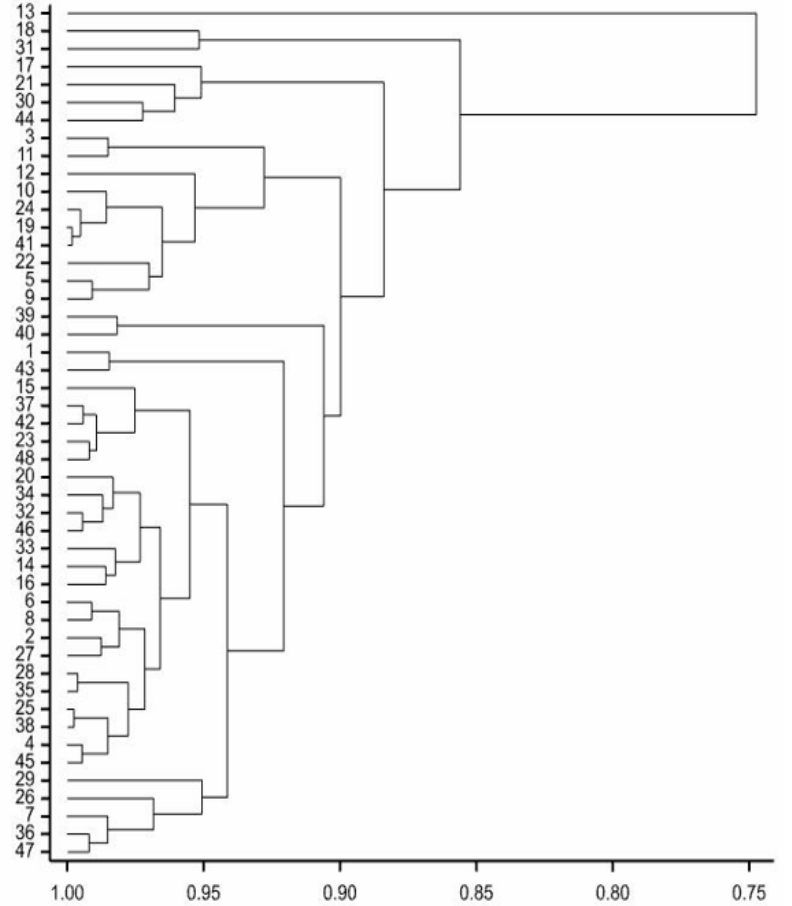
Figure 10. Dendrogram of differences between analysed Abies alba genotypes verified by the cluster analysis using the nearest neighbour method and Euclidean distances on the basis of eight traits (length of polar axis—P, equatorial diameter—E, width of the base of saccus—A, length of saccus—B, exine thickness—Exp, and P/E, Exp/P and A/B ratios). Numbers from 1 to 48, see Table 1. Individual traits were of different importance and had a different share in the joint multivariate variation. The study on the multivariate variation for A. alba genotypes also included the identification of the most important traits in the multivariate variation of the genotypes. Figure 10 shows the variability of the eight quantitative traits of 48 studied A. alba genotypes. In the graph, the coordinates of the point for particular genotypes are the values for the first and second canonical variables. The first two canonical variables accounted jointly for 59.77% of the total multivariate variability between the individual genotypes (Table 4, Figure 11). The most significant, positive, linear relationship between the first canonical variable was found for P/E and Exp/P (Table 3). The first canonical variable negatively correlated with P, E, A and A/B (Table 4). The second canonical variable significantly positively correlated with P, B, Exp, P/E, and Exp/P and negatively correlated with A/B (Table 4). The greatest variation in terms of all eight traits (measured by Mahalanobis distances) was found for genotypes 13 and 30 (the Mahalanobis distance between them amounted to 4.69) (Table A3). The greatest similarity was found for genotypes 37 and 42 (0.44).